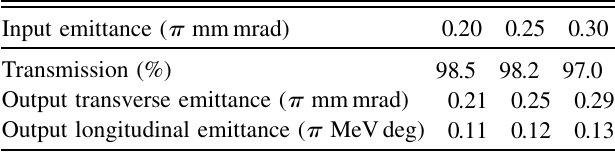
TABLE IV. Input-transverse-emittance dependence of the RFQ III